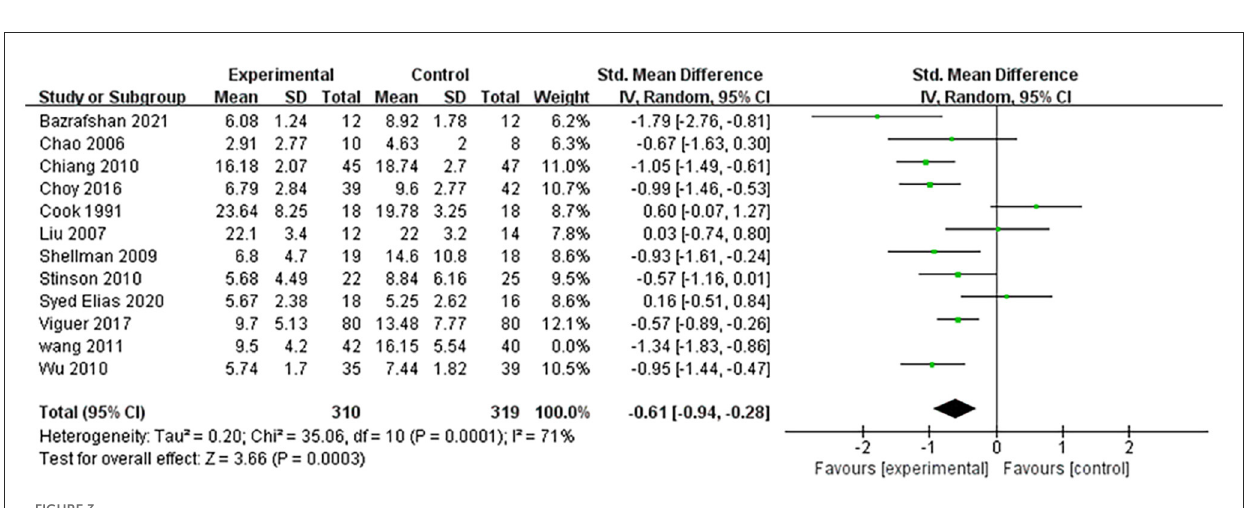
FIGURE3 Effect size of the reminiscence therapy group vs. the control group on depression rating scores.